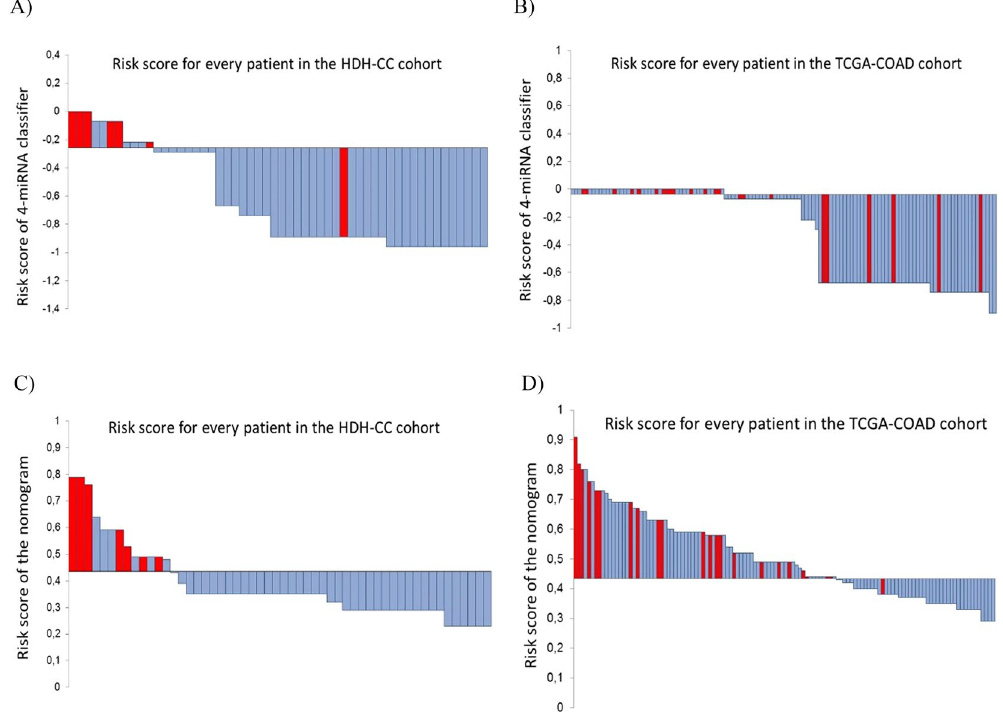
Figure 3. Risk score for every patient in the HDH-CC cohort ( A ) and in the TCGA-COAD cohort ( B ) based on the four-miRNA classifier alone. Risk score based on the nomogram in the HDH-CC cohort ( C ) and in the TCGA-COAD cohort ( D ). Red illustrates patients experiencing recurrence and blue illustrates patients with no